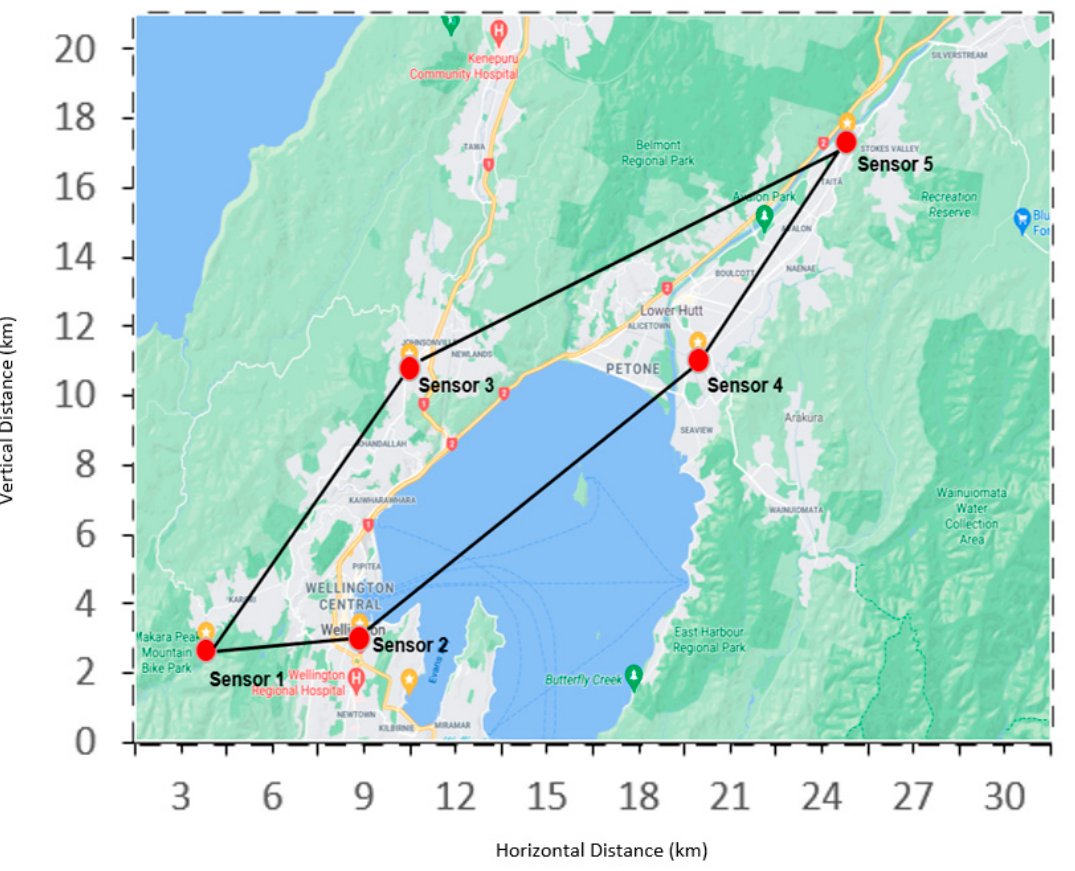
Figure 5. Installed Raspberry Shake sensors in the Wellington region.